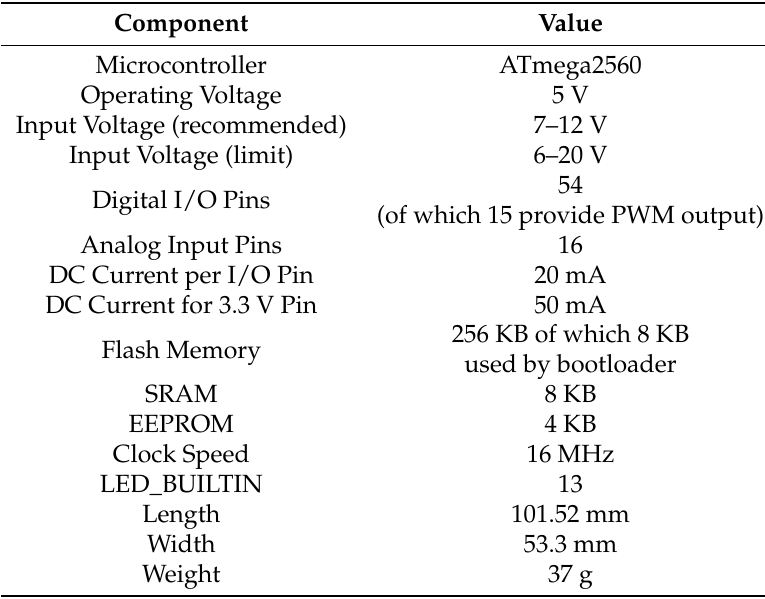
Table 1. Arduino Mega